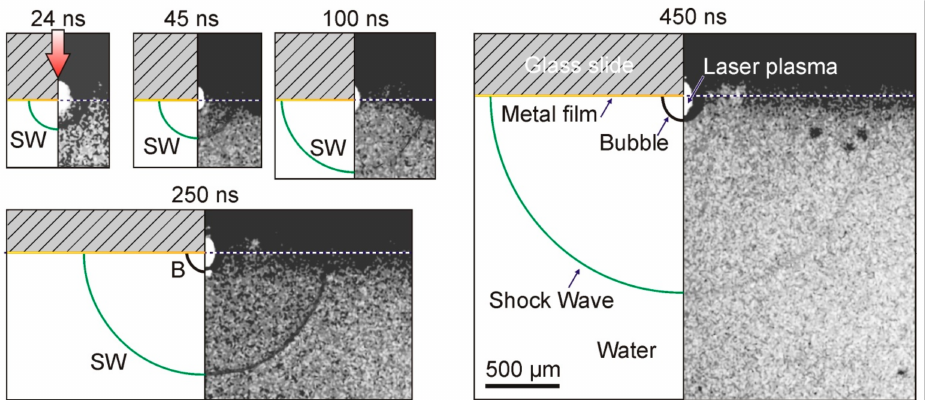
Figure 6. A sequence of frames obtained using time-resolving shadow microscopy during the generation and propagation of a shock wave (SW) in water under the impact of a laser pulse with a duration of τ = 8 ns and an energy of E = 68 µ J on the absorbing Ti layer in Configuration 2 (Figure 1B). Each frame shows the time after exposure to the laser pulse. In the last two frames, an expanding vapor–gas bubble (B) is recorded near the area of laser exposure. On the left side of each frame, a section of a donor plate with a glass slide, an absorbing metal layer, and the fronts of an expanding bubble and a shock wave are schematically shown. The red arrow in the first frame shows the direction of the laser